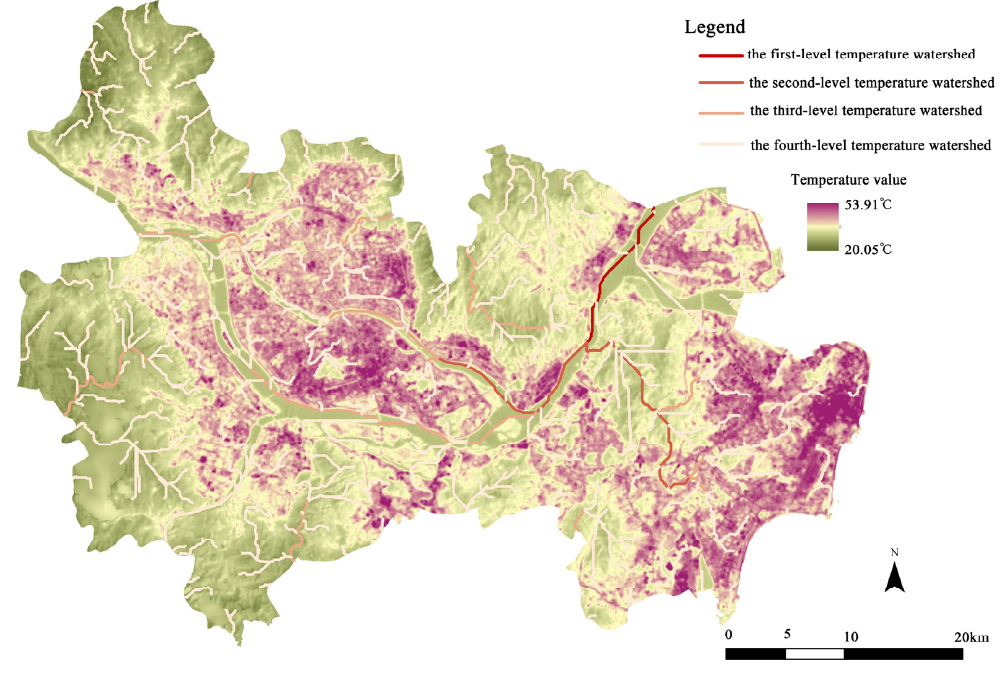
Figure 4. Spatial distribution of temperature watershed. Table 1. Spatial distribution of temperature